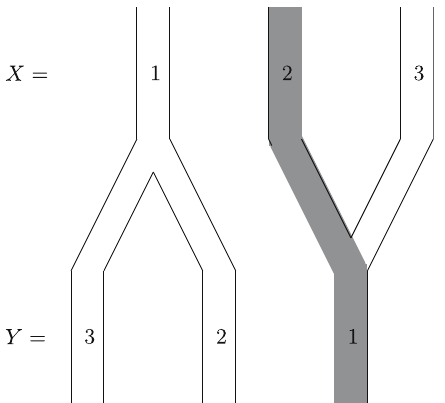
Figure 3: For the gray path with unknown direction, it is more likely that the ball entered from the top than from the bottom according to causal